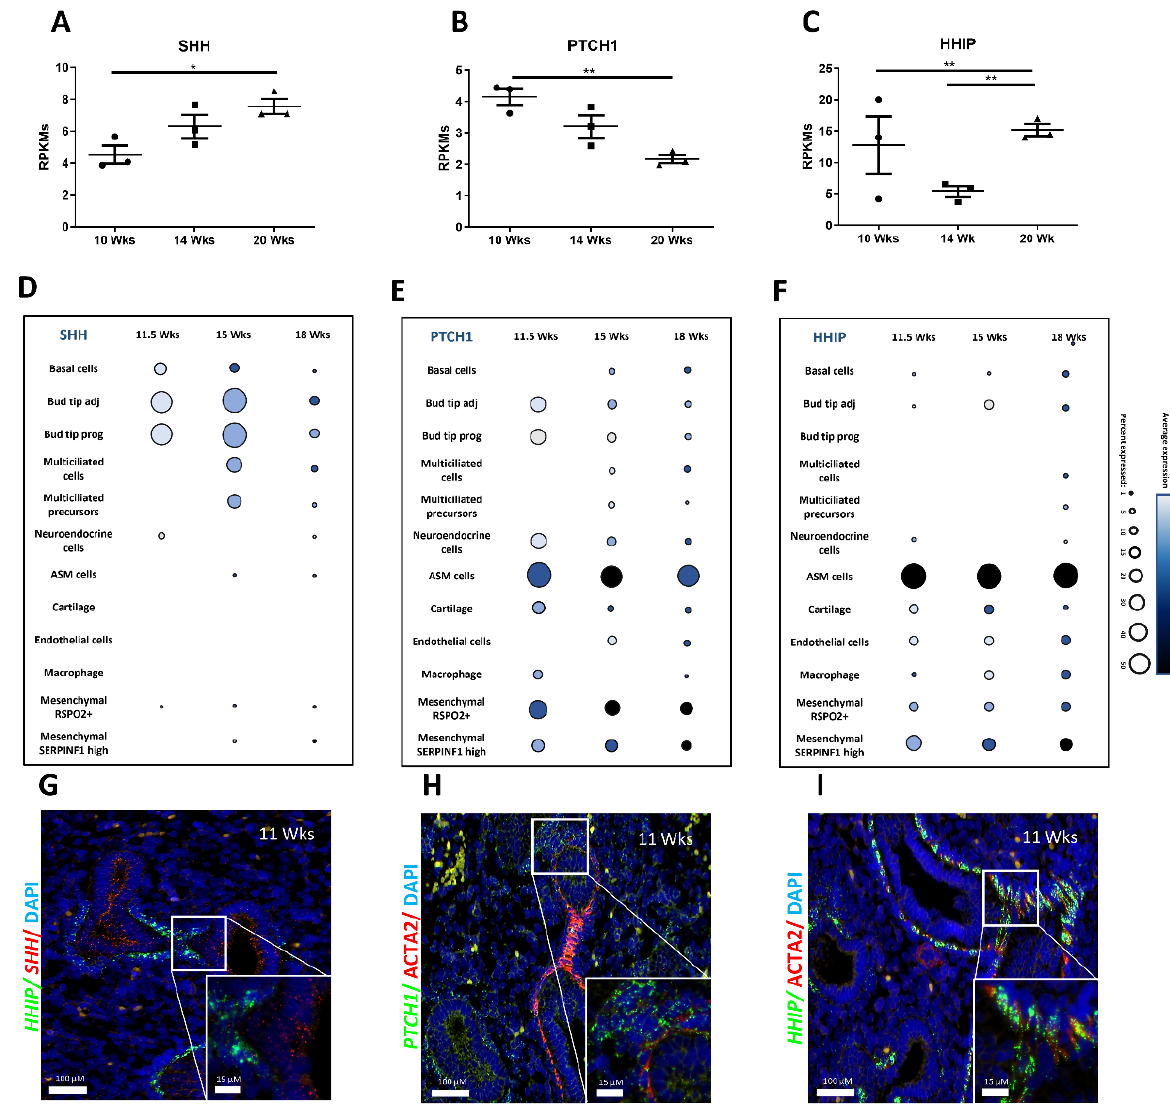
Figure 1. Spatiotemporal expression of Hedgehog pathway components is finely tuned during human lung development. Gene expression of SHH ( A ), PTCH1 ( B ), and HHIP ( C ) expressed in RPKMs ± SEM within the developing lung at 10-, 14- and 20-week gestation ( n = 3 per time point, * p < 0.05, ** p < 0.01). ( D – F ) Dot plots show the percentage of cells expressing SHH ( D ), PTCH1 ( E ), and HHIP ( F ) using dot size and the average expression level of that gene based on unique molecular identifier (UMI) counts. ( G – I ) Fluorescent in situ hybridization (FISH) on 11 wks gestation fetal human lung sections showing SHH (red) and HHIP (green) ( G ); PTCH1 (green) with ACTA2 (IF, red) ( H ) and HHIP (green) with ACTA2 (IF, red) ( I ). Scale bars are 100 µm for large insets and 15 µm for small insets.